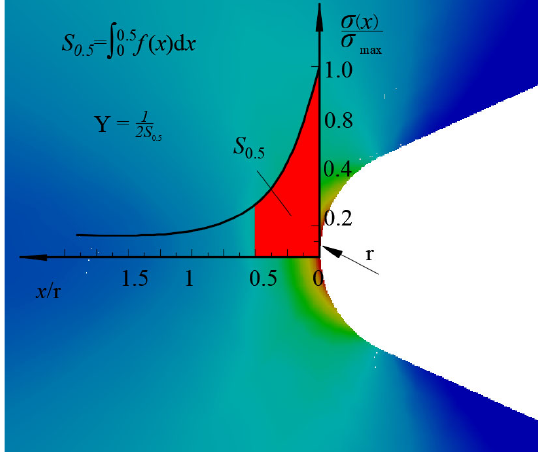
Figure 3. Definition of stress gradient factor.